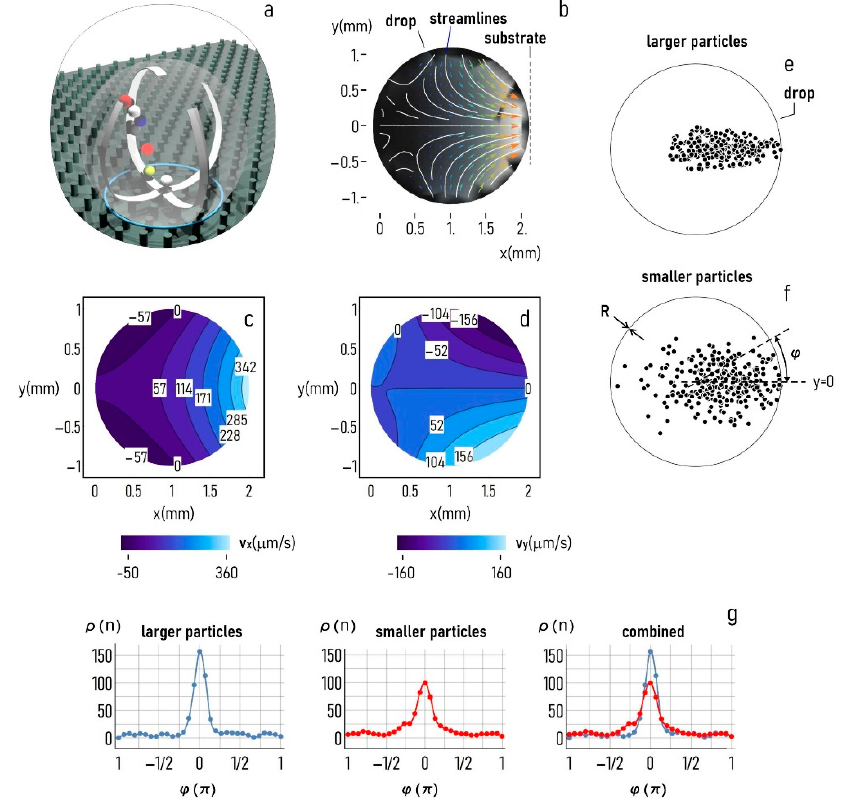
Figure 7. The substrate used in the study uses super-hydrophobic surfaces for maintaining solutions in a quasi-spherical shape ( a ). Because of its curvature and a temperature gradient, in the drop, develop convective flows with characteristic streamlines reported in ( b ) and values of velocity along the horizontal ( x ) ( c ) and vertical ( y ) ( d ) direction that vary between 0 and a maximum of ∼ 350 µ m/s for the x coordinate and of ∼ 150 µ m/s for the y coordinate. The flow fields determined experimentally were used to estimate the transport of large (36 µ m–( e )) and small (3 µ m– ( f )) particulates within the droplet. The particle density plot against the position in the drop reported for different particle sizes ( g ) illustrates that larger particles are mostly transported toward the center of the